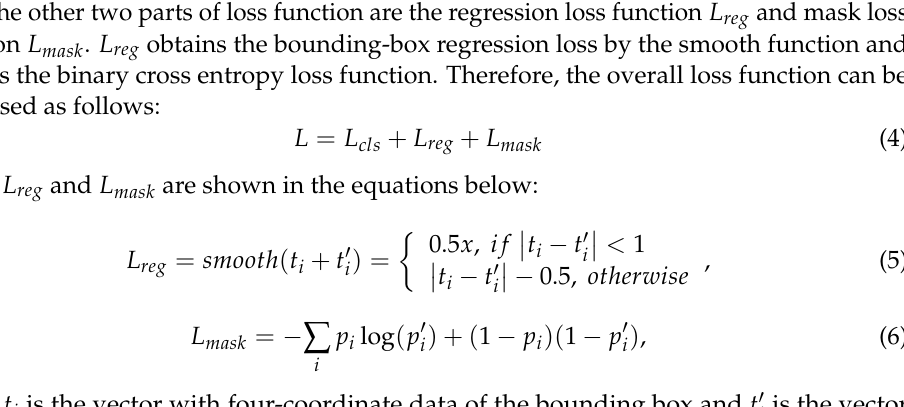
Figure 3. Arcface loss theory. ∗ indicates multiplication.